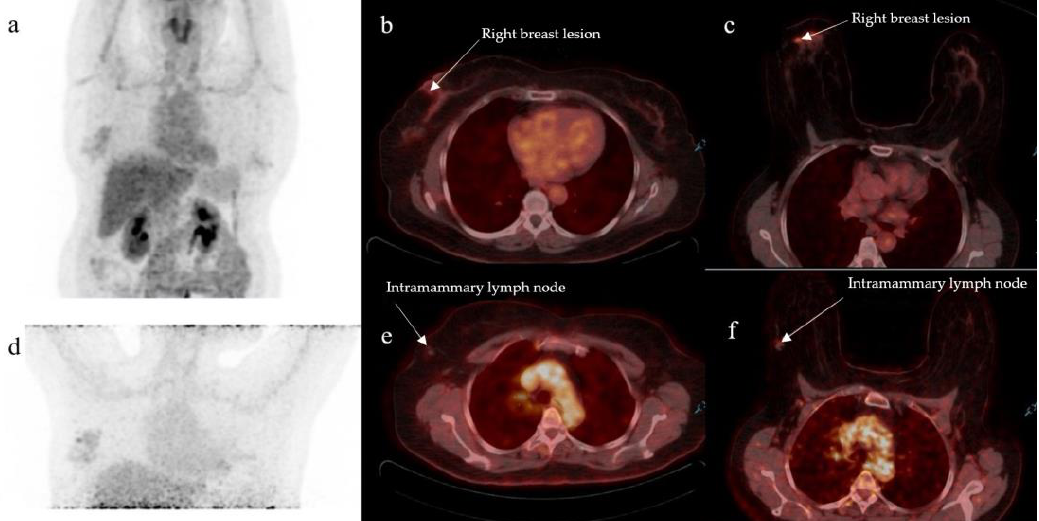
Figure 4. MIP images ( a , d ) showing uptake in the right breast. Fused axial PET/CT cuts showing faintly FDG-avid on supine right breast lesion ( b ), which is better visualized on prone ( c ). An intra-mammary lymph node appears non-radiotracer avid on supine ( e ) while it appears avid on prone ( f ).